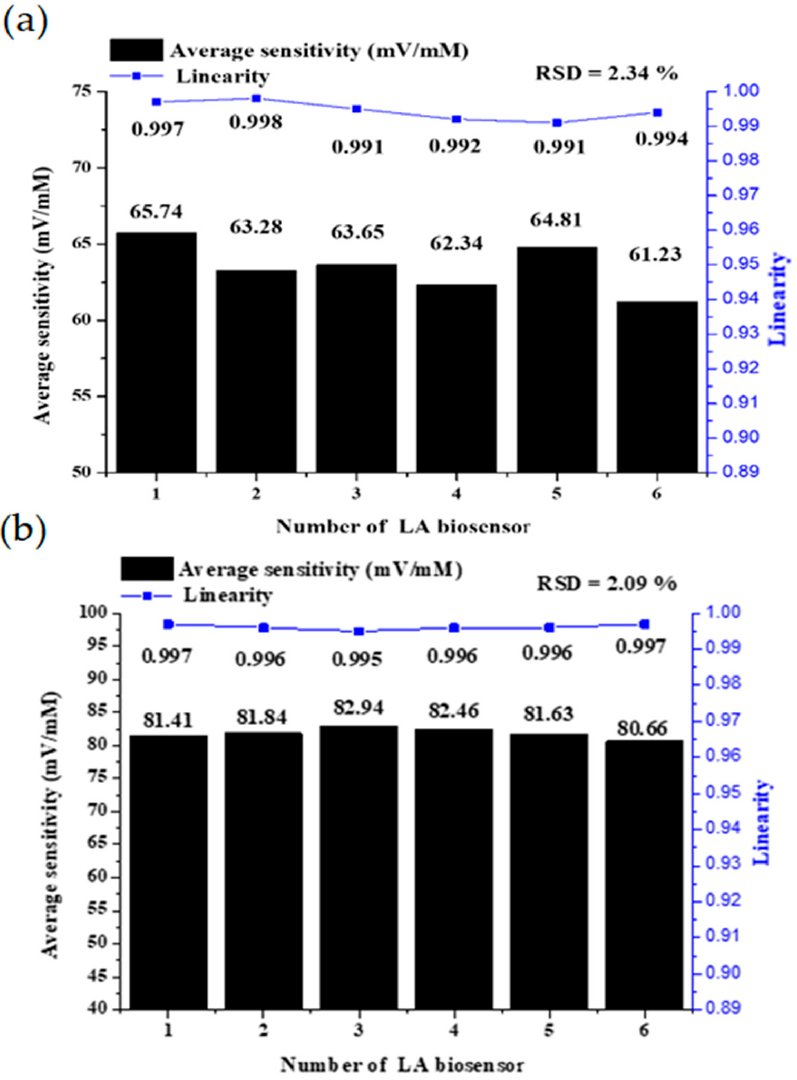
Figure 11. The reproducibility of RuO 2 LA biosensors. ( a ) Static measurement; ( b ) dynamic microfluidic measurement.